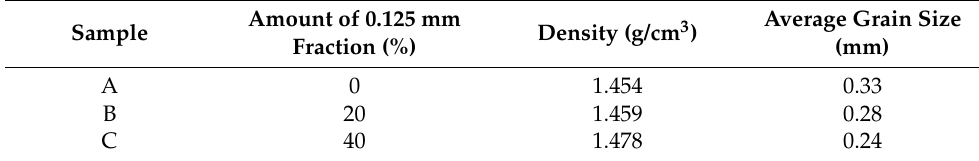
Table 2. Properties of the studied furan samples.